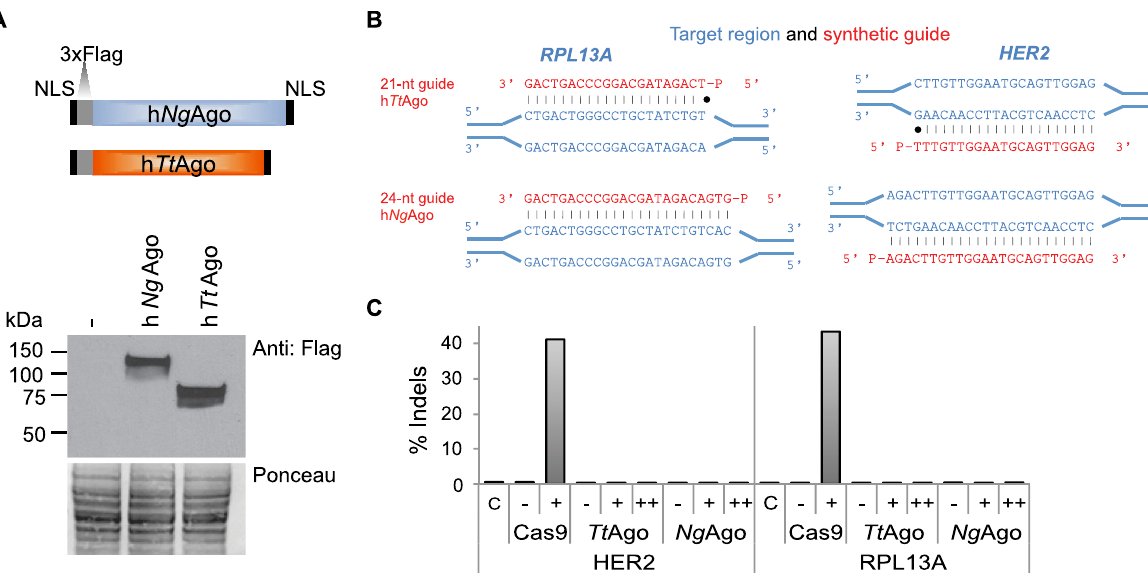
Fig 2. h Tt Agoand h Ng Ago do not cleave genomic target sites. A. Schematic of human codon-optimized Tt Ago and Ng Ago proteins containing two nuclear localization signals (NLSs) and a 3xFlag epitope tag. Western blot analysis of h Tt Ago and h Ng Ago proteins in HEK293 cells using an antibody against the 3xFlag tag. Untransfected cells serve as a negative control (-). Ponceau staining was used as a loading control. B. Diagram illustrating RPL13A and HER2 guide DNAs and genomic target site. Genomic target sites are indicated in blue and complementary ssDNA guides are indicated in red. C. Amplicon sequencing was carried out on HEK293 cells co-transfected with h Tt Ago or h Ng Ago expression plasmids with (+) or without (-) gDNAs to RPL13A and HER2 .To increase the amount of gDNAs, cells were re-transfected with gDNAs 24 hours after the initial transfection (++). CRISPRESSO analysis confirms that h Tt Ago and h Ng Ago did not cause insertions or deletions (indels) under any of these conditions (S5 Table). As a control, HEK293 cells were co-transfected with Cas9 nuclease and gRNA expression plasmids targeting RPL13A and HER2 .RNA-guided Cas9 displayed target site cleavage at the genomic RPL13A and HER2 target sites. The percentage of sequence reads containing indels relative to the total number of sequence reads is plotted on the